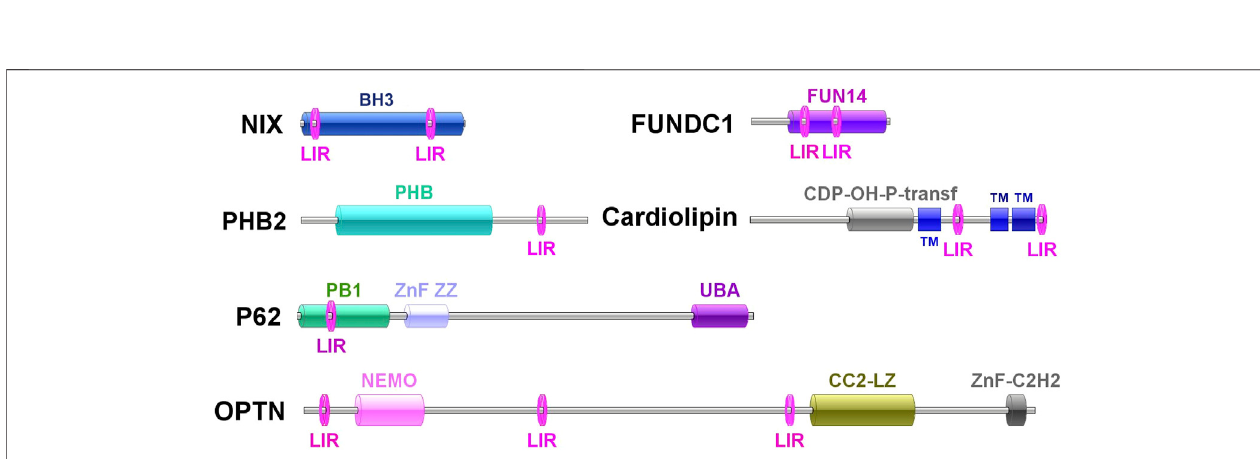
FIGURE 1 | Autophagic ultrastructures in CCCP-treated hemocytes by transmission electron microscopy. (A) Autophagic ultrastructures of hemocytes in CCCP- treated hemocytes. AC: autophagosomes. (B) Number of autophagosomes in CCCP-treated hemocytes. *: p < 0.05 ( t -test).